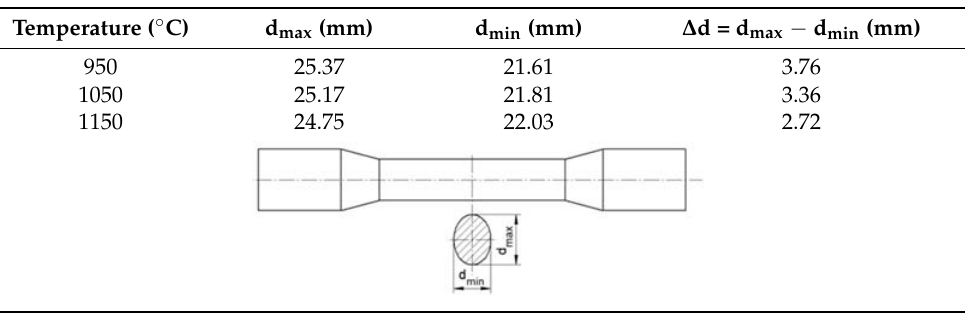
Table 1. Ovalisation sizes of the cross-section of forgings.